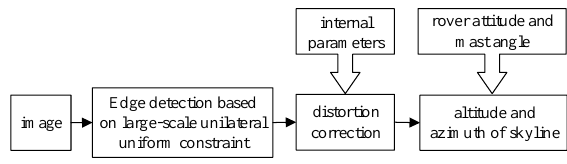
Figure 6. Flowchart of skyline calculation for